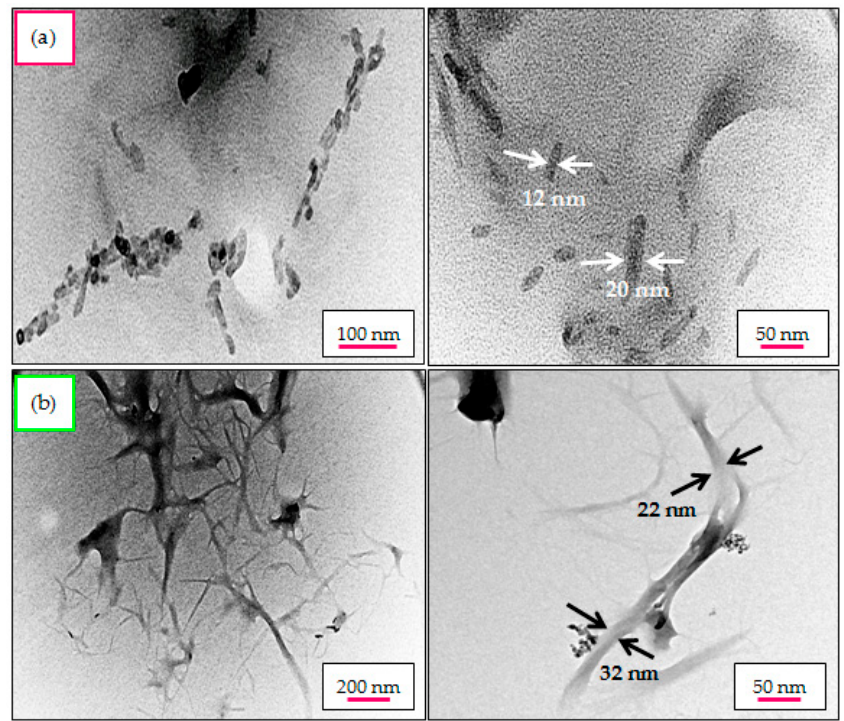
Figure 5. TEM micrographs of nanocellulose treated by: ( a ) H 2 SO 4 ; and ( b ) Cr(NO 3 ) 3 catalyst, highlighting the different morphologies observed in both different cellulose nanomaterials ( right image has a larger magnification than left image).